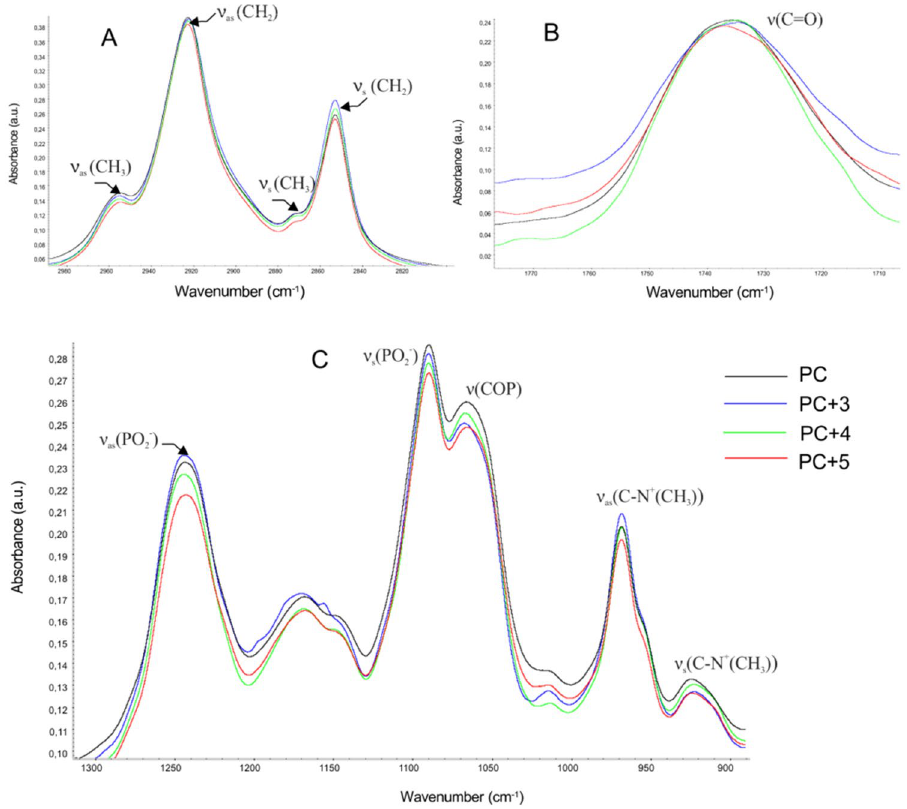
Figure 4. FTIR spectra of PC liposome’s and of PC modified with flavonoids, concentration of compounds 50 µM; ( A ) C–H stretching regions, ( B ) carbonyl band, ( C ) phosphate and choline bands of